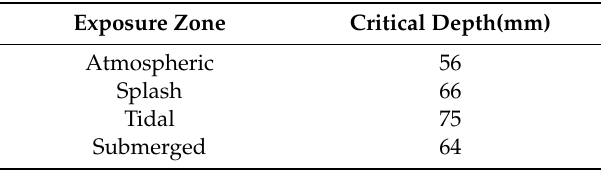
Table 4. Penetration depth calculated using Equation